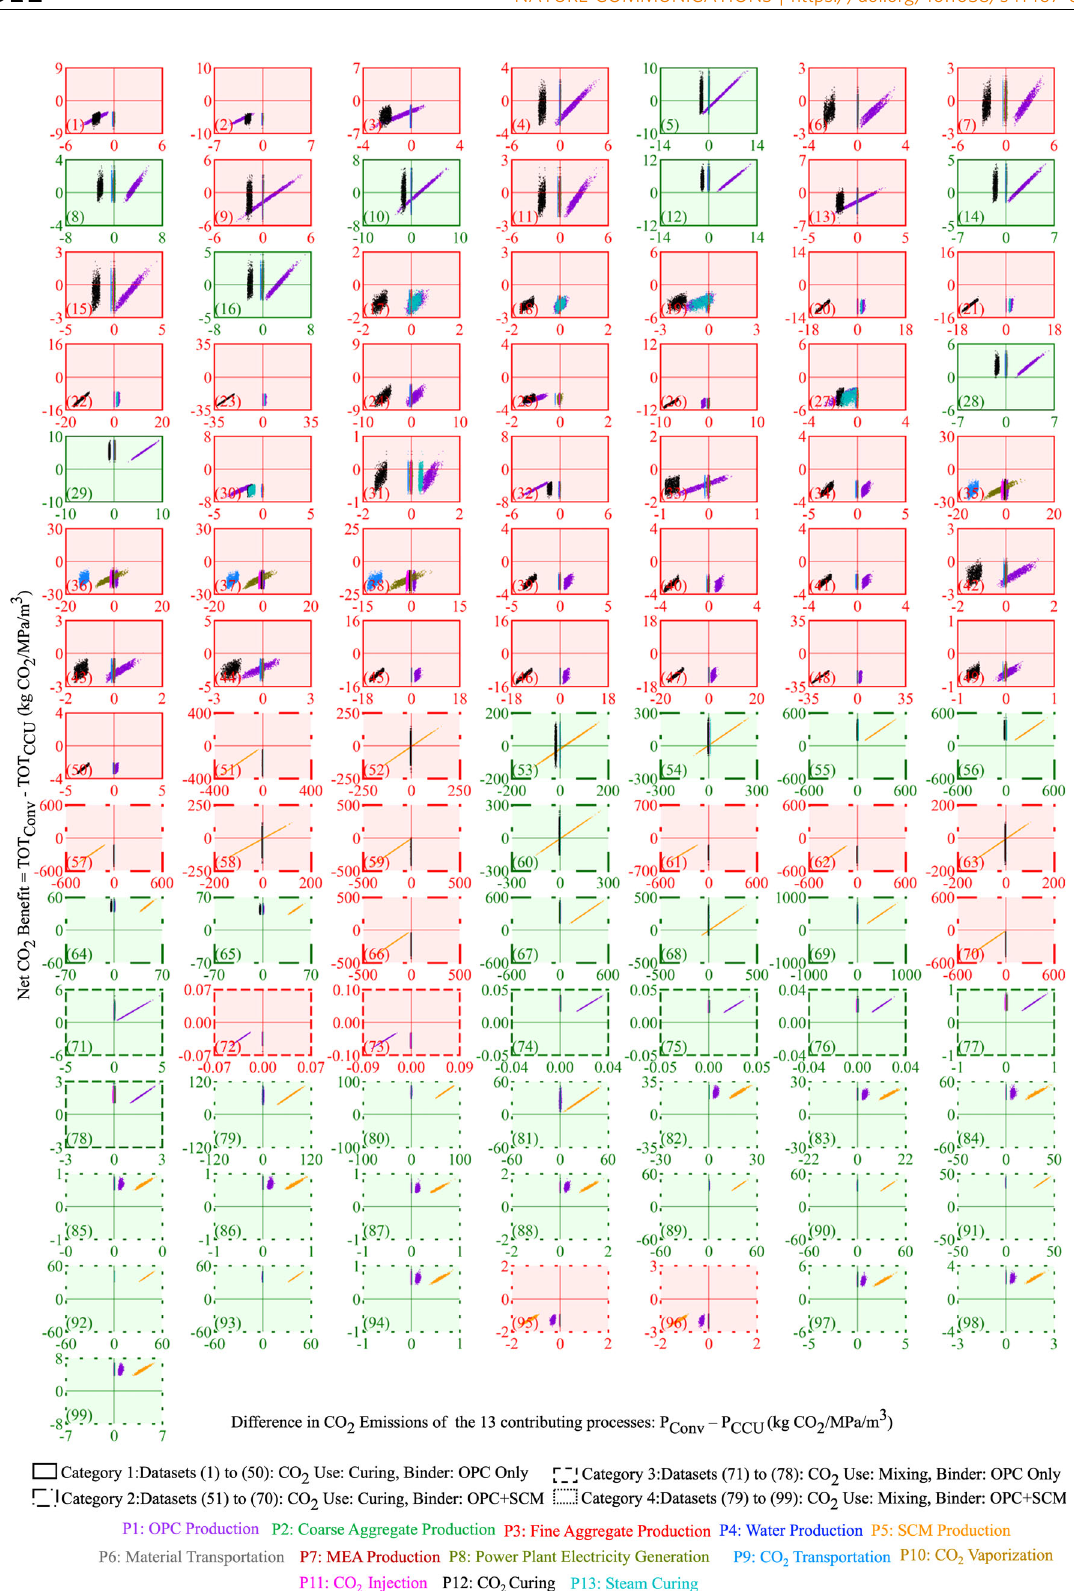
Fig. 4 Scatter plot analysis to determine the impact of the 13 processes on the net CO 2 bene fi t across the 99 datasets. The difference between the CO 2 emissions from the 13 processes of CCU and conventional concrete production is plotted on the x -axis and the net CO 2 bene fi t is plotted on the y -axis. The parenthesized value in the lower left corner is the dataset number. Higher resolution scatter plots for each of the 13 processes can be downloaded from SI Section 9 Supplementary Table